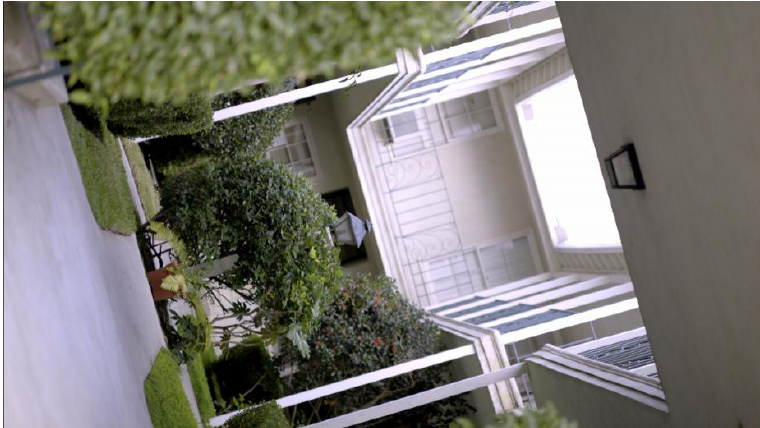
Figure 3. Kerry Tribe, still from The Aphasia Poetry Club (2015), three-channel video with sound, 28:27 min.